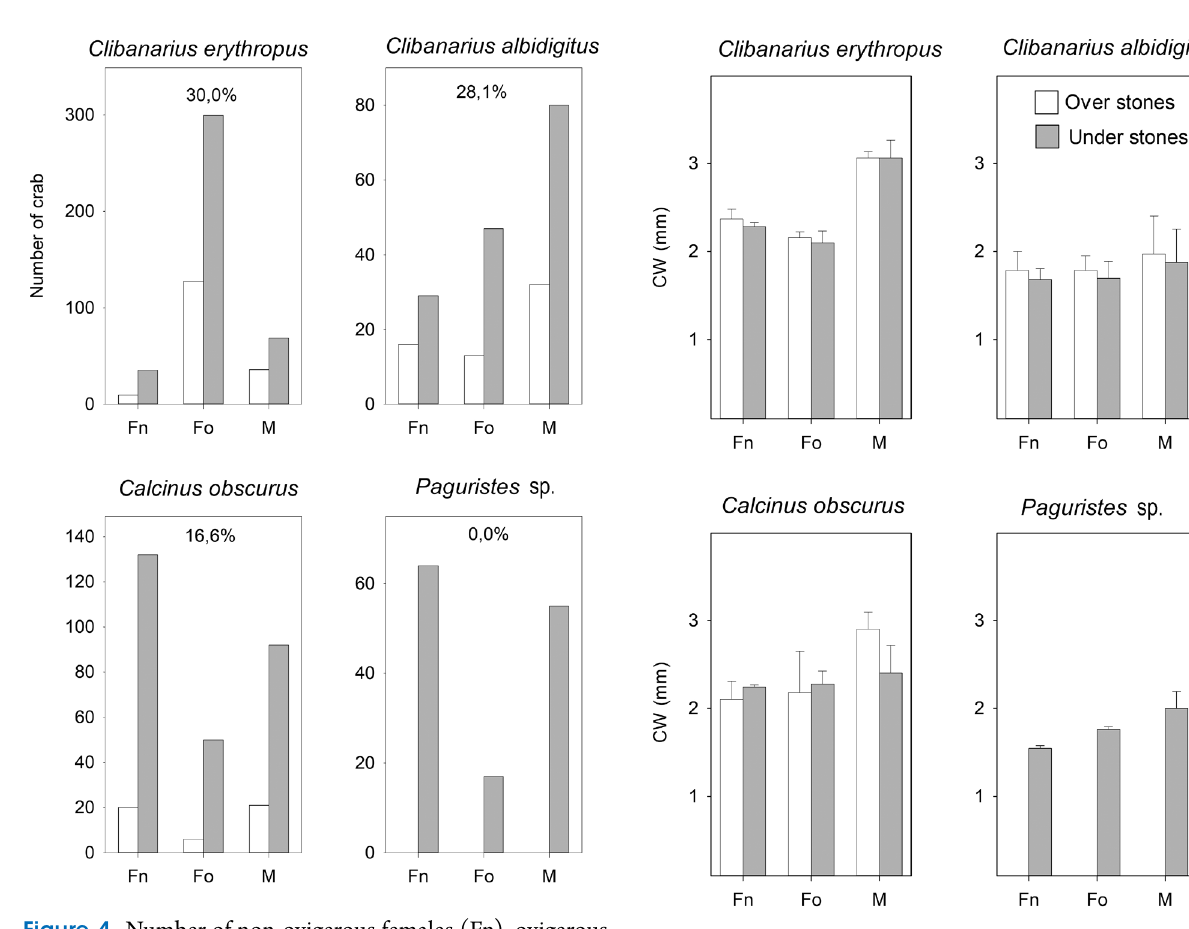
Figure 5. Mean shield width (+SE) of non-ovigerous females (Fn), ovigerous females (Fo) and males (M) for each hermit crab species, which were exhibiting air-exposure behavior on rocks (open bar) and those clustering under rocks (filled